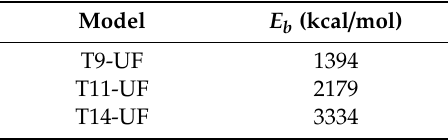
Table 2. The binding energy of three models.